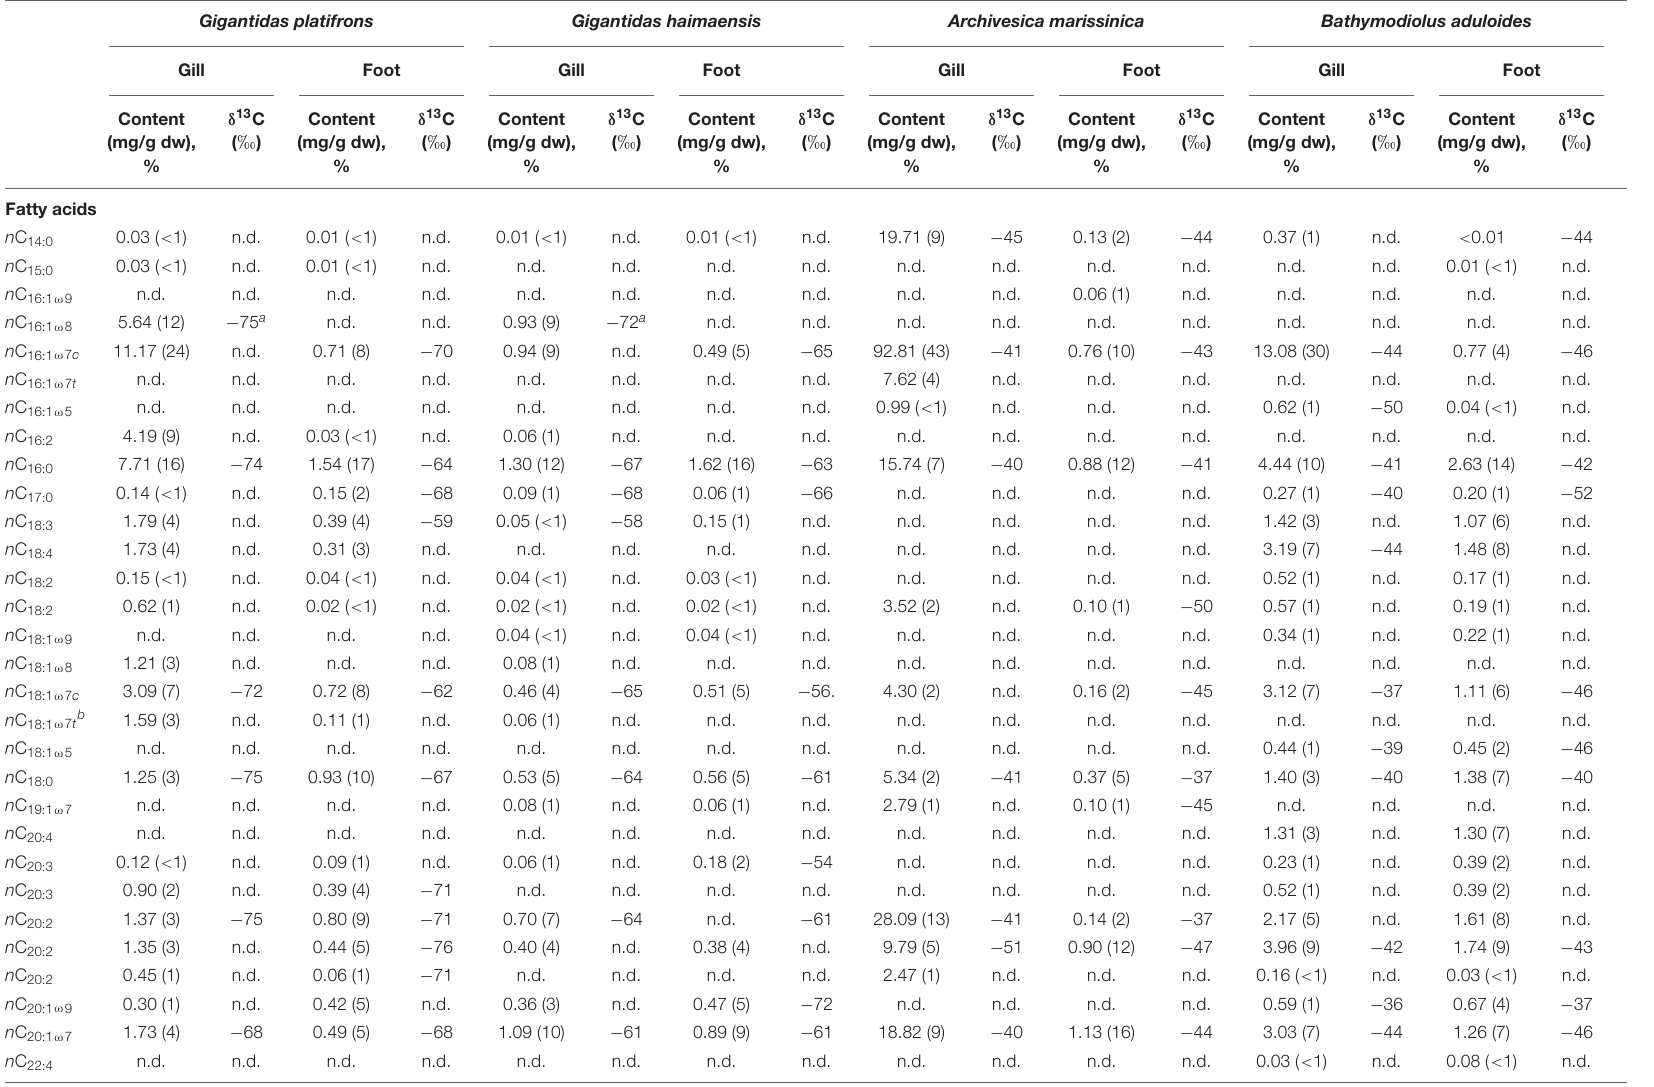
TABLE 2 | Contents and isotopic compositions of fatty acids (FAs) from bivalve tissues. Gigantidas platifrons Gigantidas haimaensis Archivesica marissinica Bathymodiolus